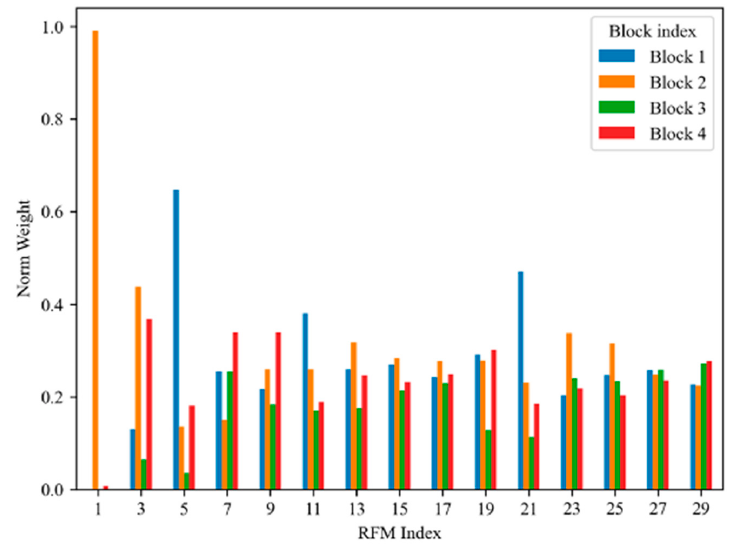
Figure 13. The norm weight of the four residual blocks in corresponding RFMs.